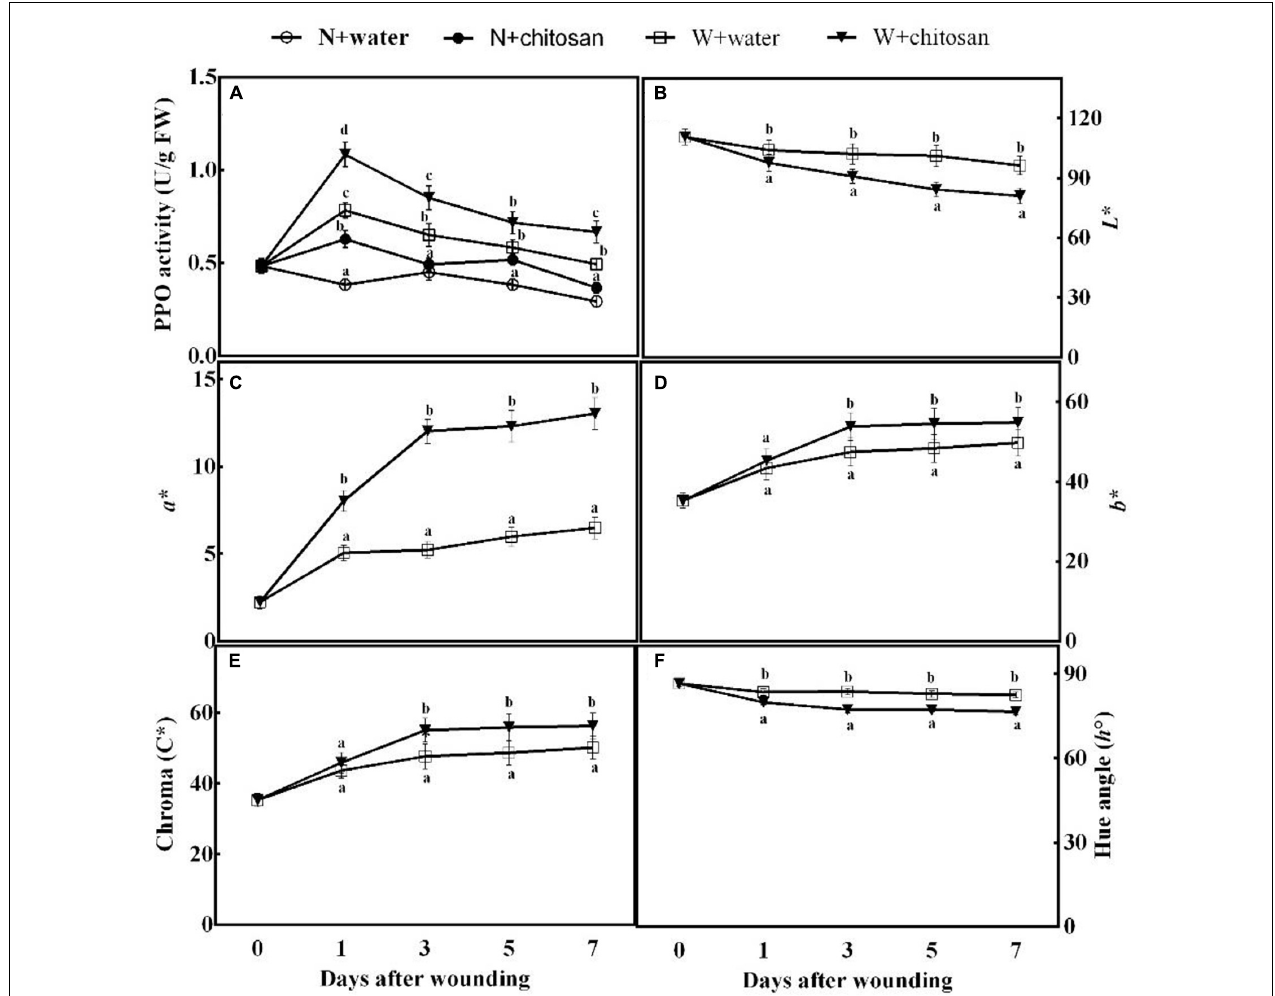
FIGURE 6 | Effect of chitosan treatment on PPO activity (A) and L* (B) , a* (C) , b* (D) , Chroma C* (E) , and hue angle h ◦ (F) . Non-wounded and treated with sterile water (N + water), non-wounded and treated with chitosan (N + chitosan), wounded and treated with sterile water (W + water), and wounded and treated with chitosan (W + chitosan). Vertical bars indicate standard error of means. Alphabets indicate significant differences ( p <